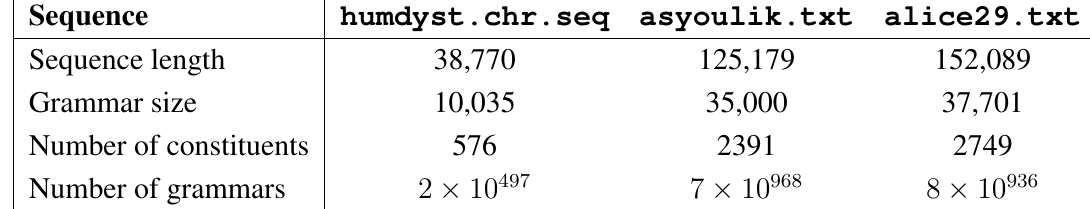
Table 3. Sequence length, grammar size, number of constituents, and number of grammars for different